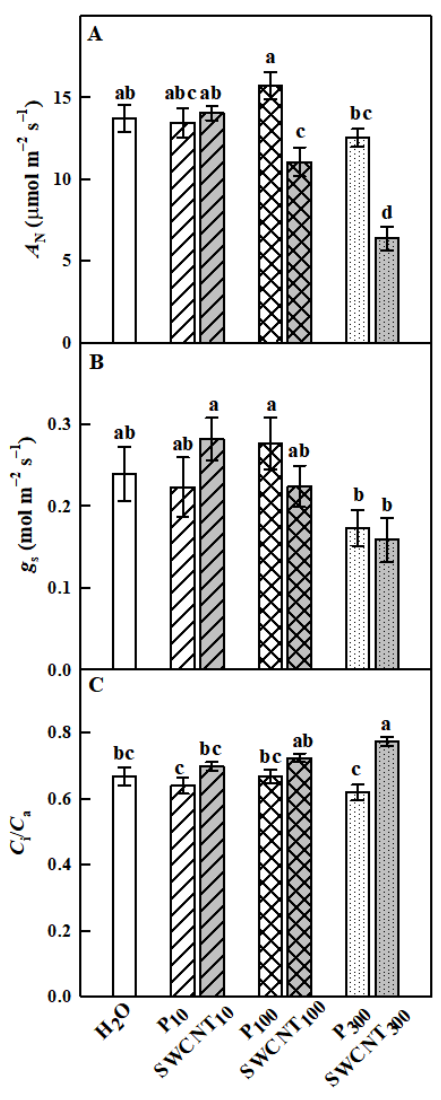
Figure 3. Effect of SWCNTs on photosynthetic gas exchange. Net photosynthesis rate ( A N , A ), stomatal conductance ( g s , B ) and intercellular CO 2 /ambient CO 2 concentration ratio ( C i / C a , C ) of pea plants seven days after spraying with “Pluronic” P-85 (P 10,100,300 ) and SWCNT 10,100,300 . Plants sprayed with H 2 O served as the control. Data are means ± SE ( n = 6). One-way analysis of variance (ANOVA) with a between-subjects factor was performed to assess statistically significant mean differences. Mean separation was performed using a Tukey’s test and statistically different means at the 5% level ( p < 0.05) are indicated with different letters.